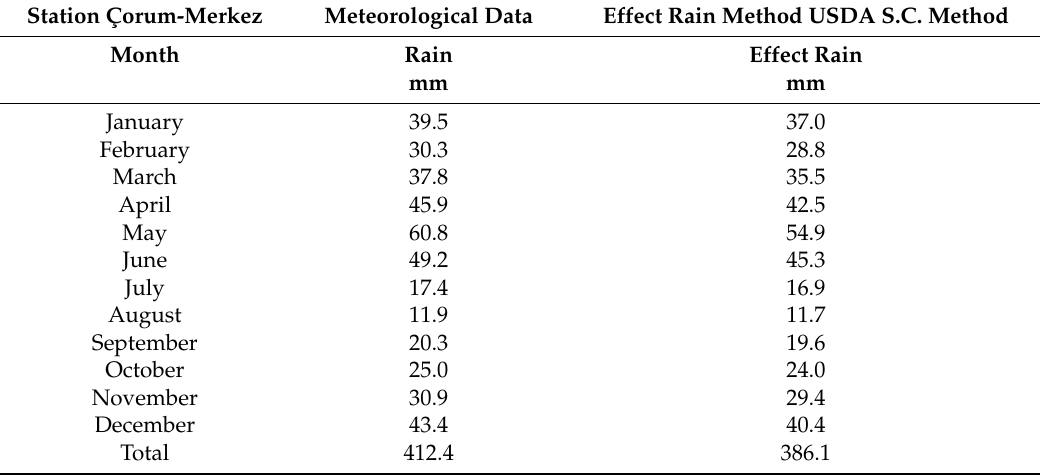
Table 2. Çorum/Center rain